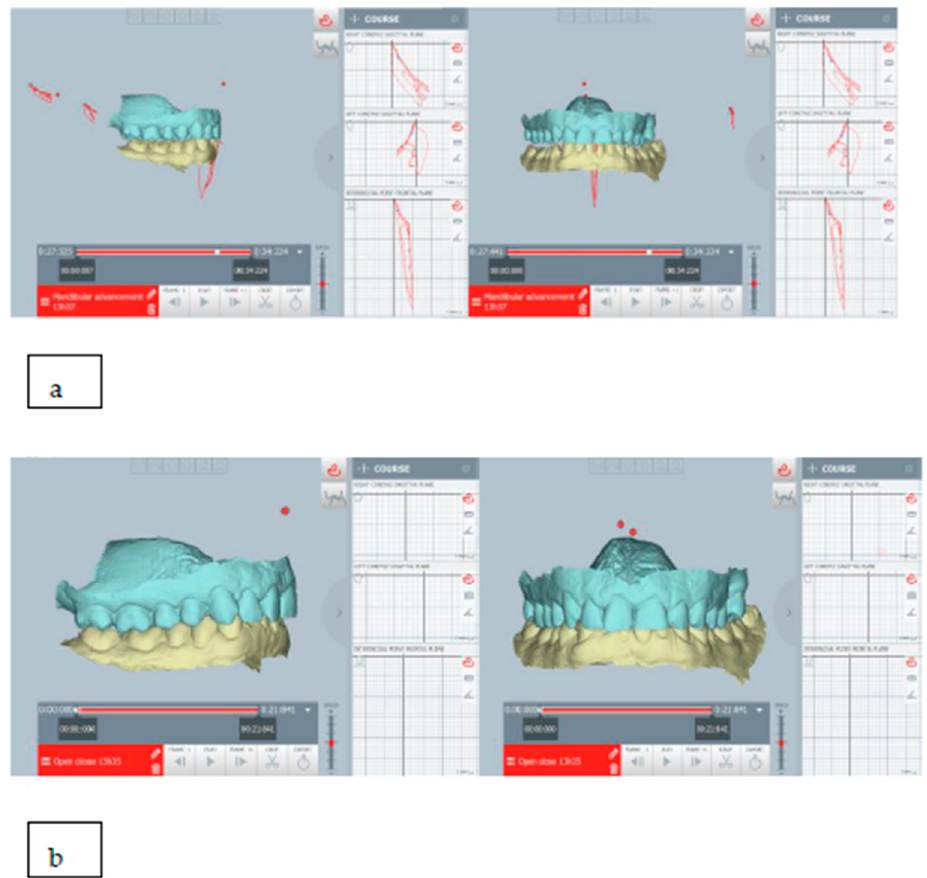
Figure 30. ( a ) The planned therapeutic position: ModJaw allowed the evaluation of kinematic tracings of the condyle from the therapeutic position and ( b ) the habitual occlusion position; as seen, it was planned as sliding downward and forward repositioning of the mandible.